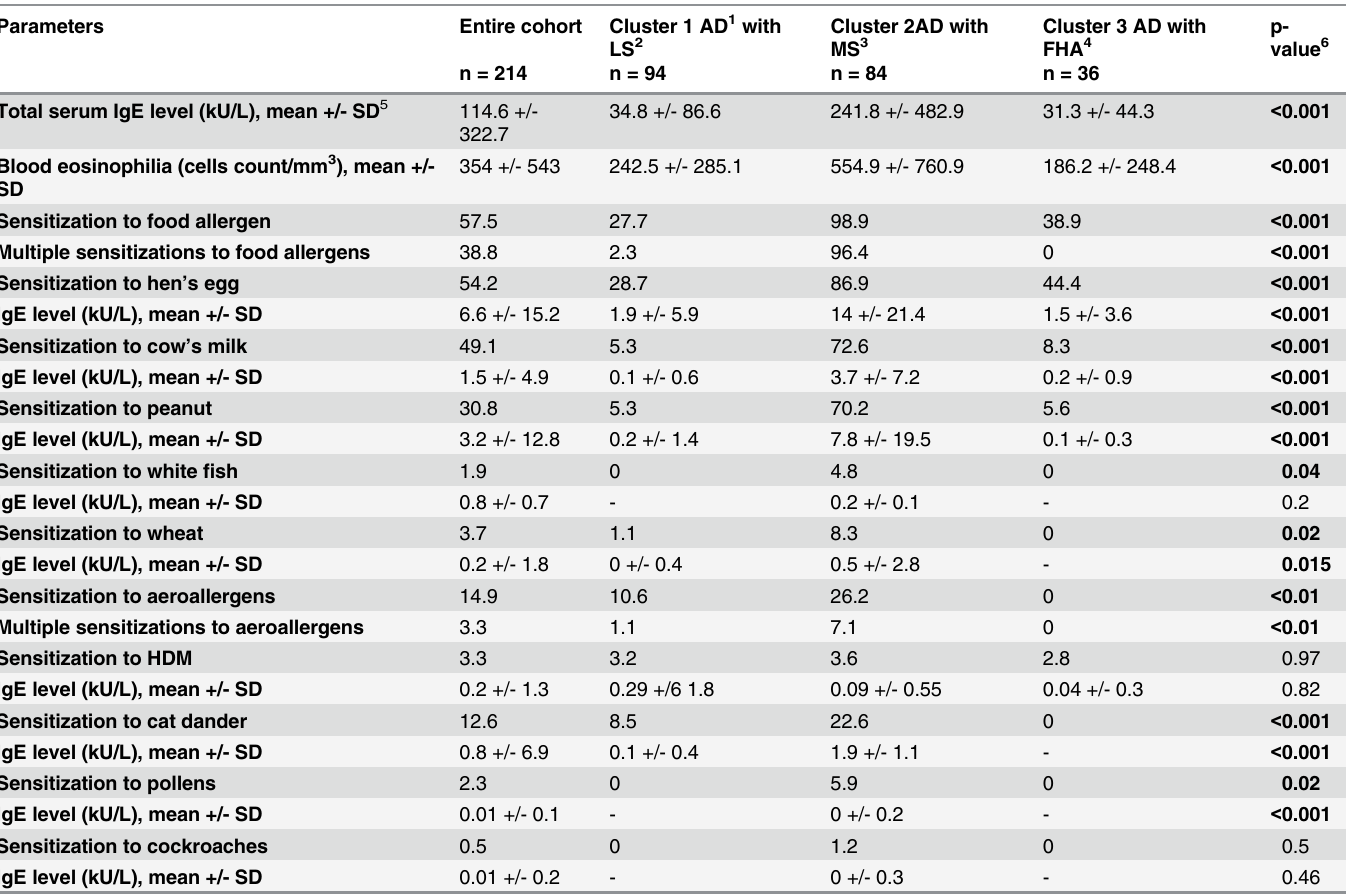
Table 2. Biological parameters at inclusion in the entire cohort and according to cluster